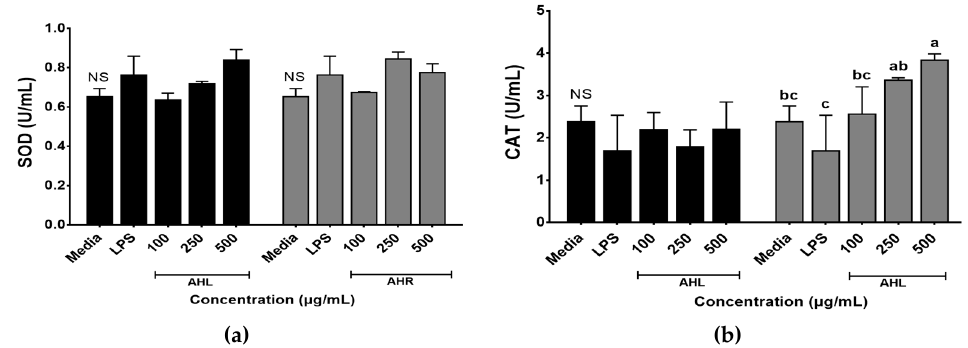
Figure 3. Enzymatic activities of A. hookeri leaves (AHL) and A. hookeri roots (AHR) extracts in RAW 264.7 cells. ( a ) superoxide dismutase activity (SOD); ( b ) catalase activity (CAT). Results were expressed as the mean ± SEM. NS Not significantly different. a–c Different letters on bars are significantly different among CAT values of AHR extract ( p < 0.05).